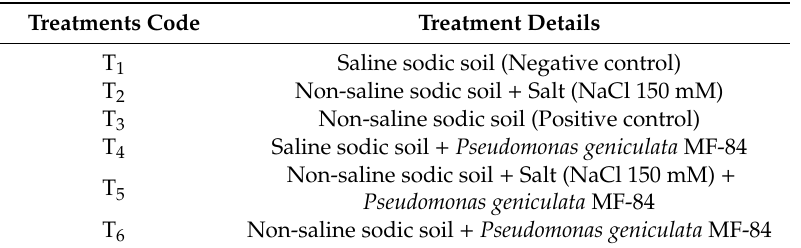
Table 2. Treatments code and